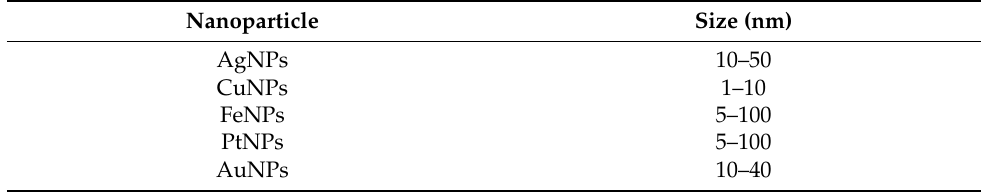
Table 4. Size distribution of nanoparticles based on TEM images.